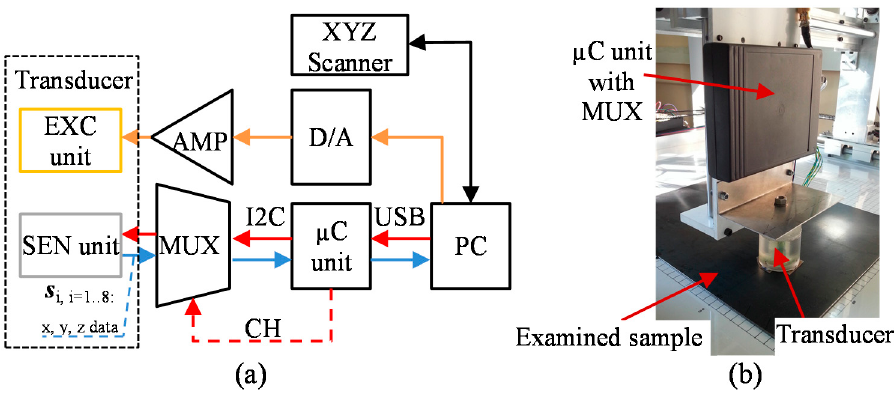
Figure 2. The utilized measuring system configuration diagram ( a ) and photo ( b ). EXC—excitation